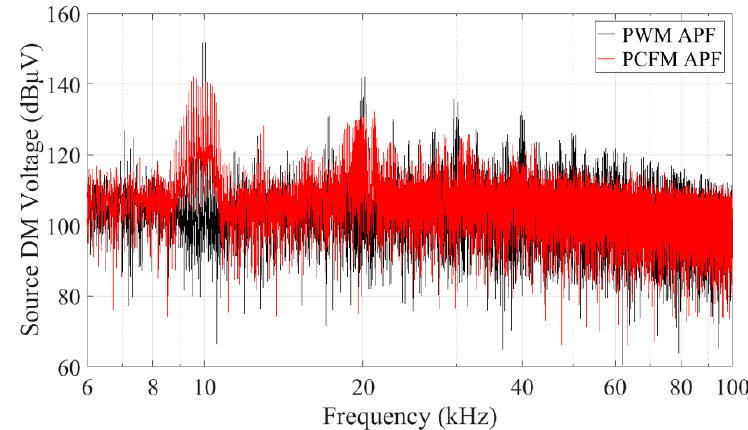
Figure 15. Experimental results of the source DM voltage v DMS spectra of APF under the nonlinear load I (Sawtooth PCFM APF with ∆ f c = 800 Hz).